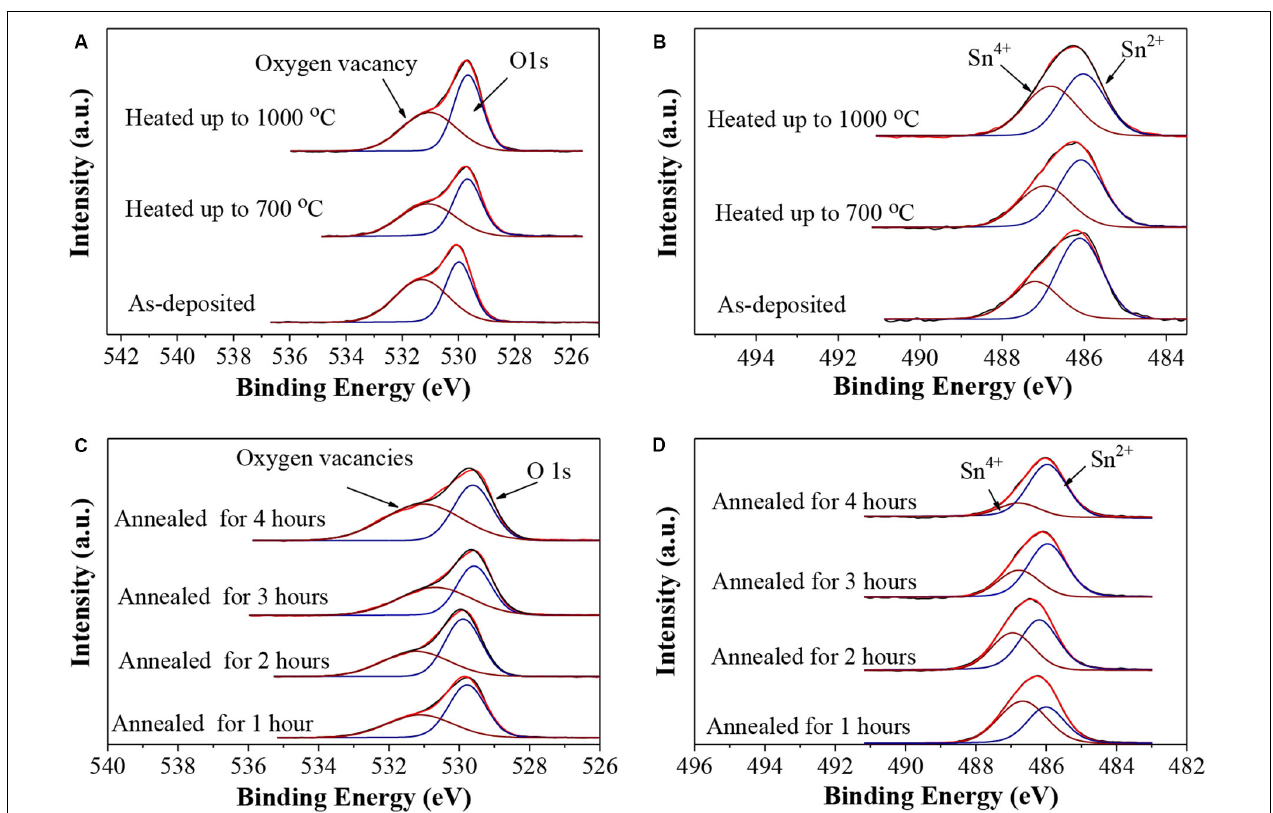
FIGURE 7 | XPS spectra in the O1s, Sn 4 + , and Sn 2 + region for the ITO films annealed at different (A,B) temperatures and (C,D) dwell times, annealed at 1,000 ◦ C.